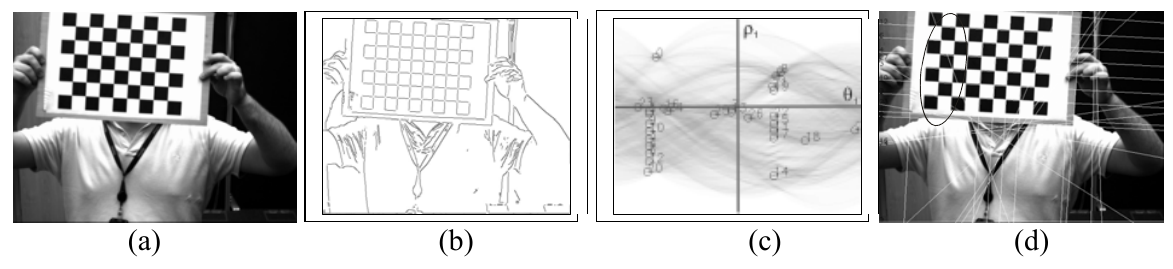
Figure 4. Results from taking a fixed number of lines. (a) Original image (b) edge image (c) Hough transform with its 36 maximums (d) detected lines.